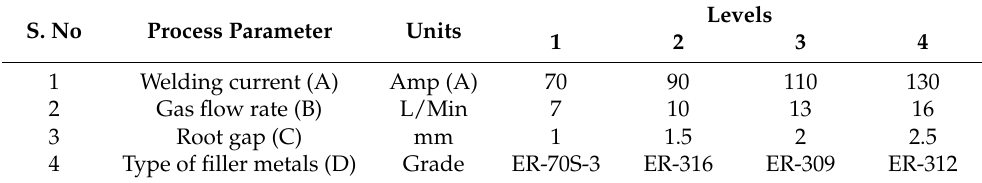
Table 6. Process parameters and levels selected.